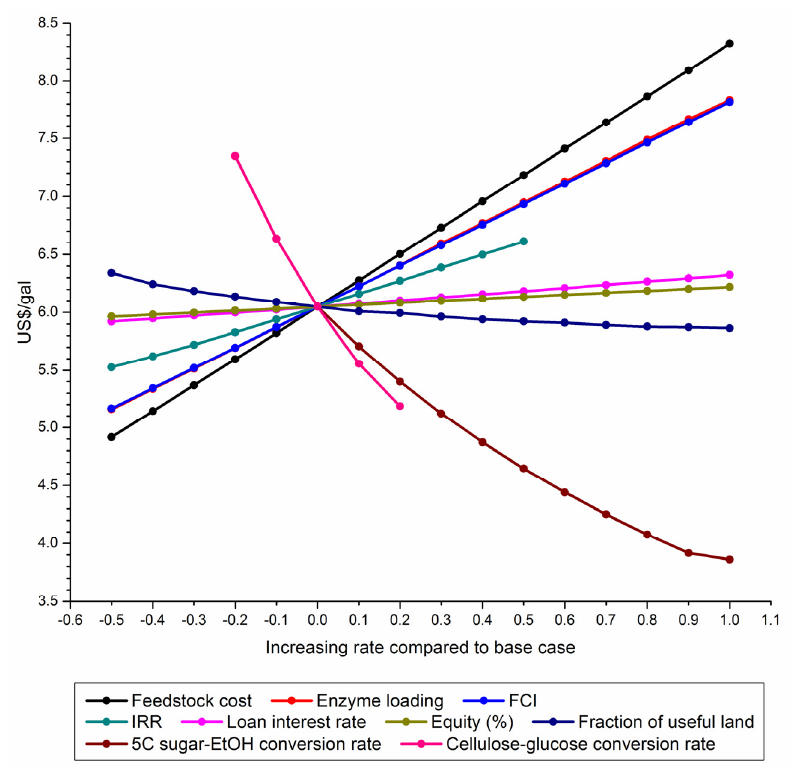
Figure 10. Sensitivity of bioethanol PGP to commonly concerned components in scenario CN_1. Note: The lines from top to bottom in the right side of the figure represent the following components: (1) feedstock cost; (2) enzyme loading; (3) FCI; (4) IRR; (5) loan interest rate; (6) equity (%); (7) fraction of useful land; (8) five-carbon sugar-EtOH conversion rate, and (9) cellulose-glucose conversion rate. It should be noticed that the lines for enzyme loading and FCI almost overlap each